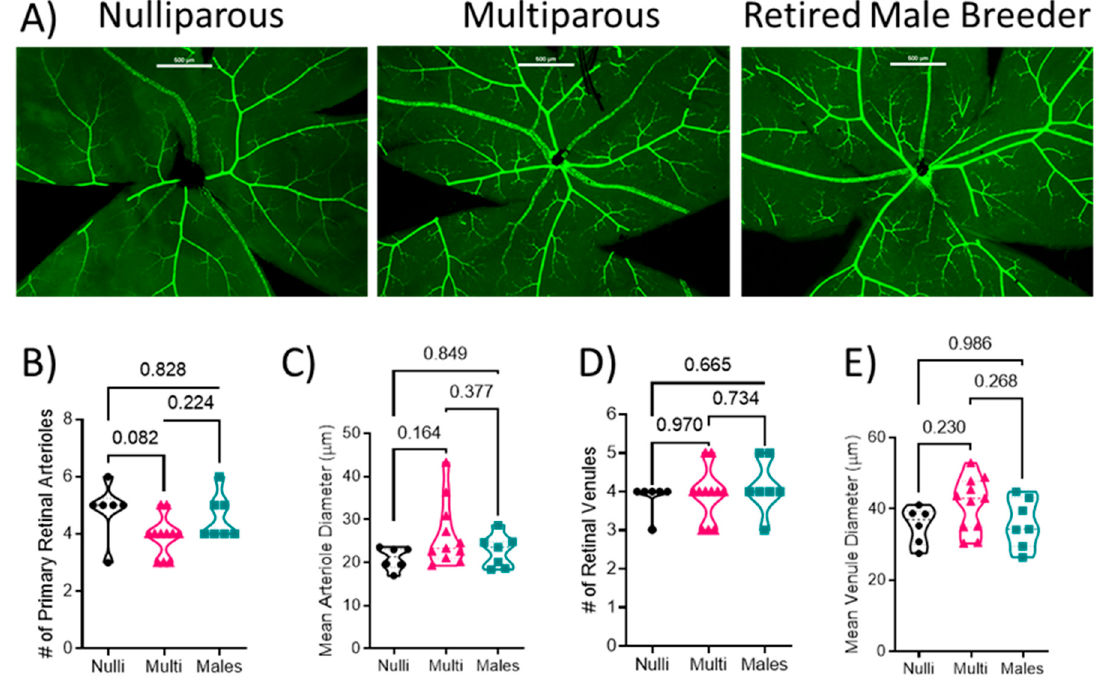
Figure 1. Quantification of retinal vascular parameters. ( A ) Representative images of the retinal mounts from each group. Scale bar represents 200 µ m. ( B ) Number of primary arterioles, ( C ) arteriolar diameter, ( D ) number of primary venules, and ( E ) diameter of venules. Mean values from 1–2 retinal mounts per mouse are shown by individual points. Thick dashed line represents the median values. p -values are indicated for each post-hoc comparison. n = 6–11 per group. Mean arteriole diameter and number of venules were analyzed using Kruskal–Wallis test followed by Dunn’s multiple comparison test. All other data were analyzed using one-way ANOVA followed by Tukey’s post-hoc test.